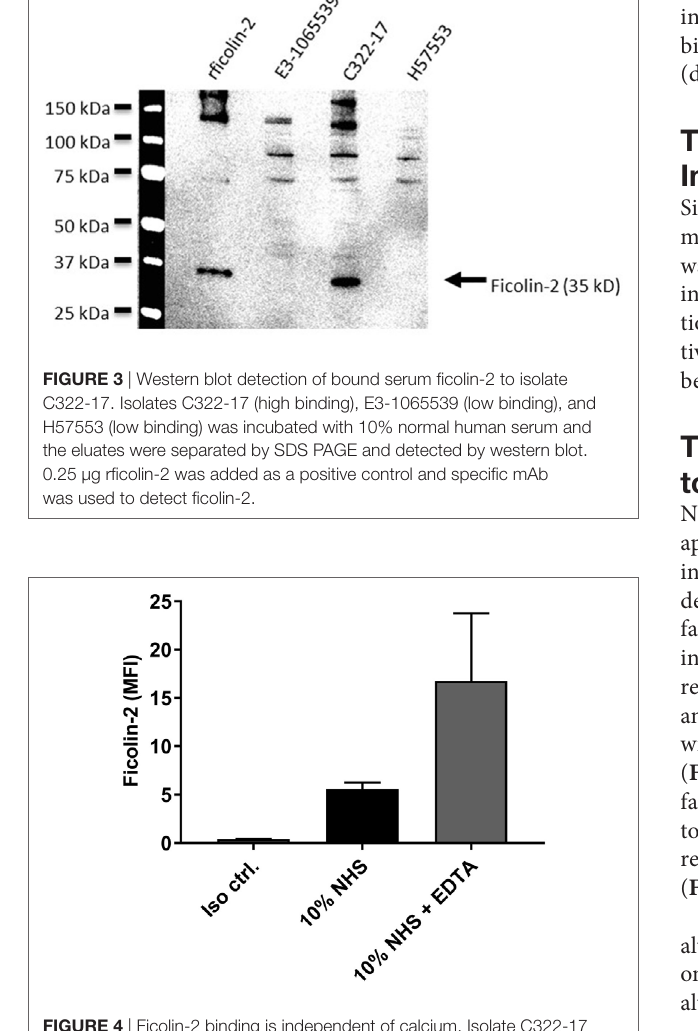
FigUre 4 | Ficolin-2 binding is independent of calcium. Isolate C322-17 was incubated with 10% normal human serum (NHS) in Barb-fetal calf serum (FCS), and 10% NHS in Barb-FCS + 10 mM ethylene diamine tetraacetic acid (EDTA). Binding of ficolin-2 was detected with specific biotinylated mAb against ficolin-2 and FITC-conjugated Streptavidin. Complement deposition was measured by flow cytometry and expressed as mean fluorescence intensity (MFI). Results represent the means of three independent experiments ± SD.